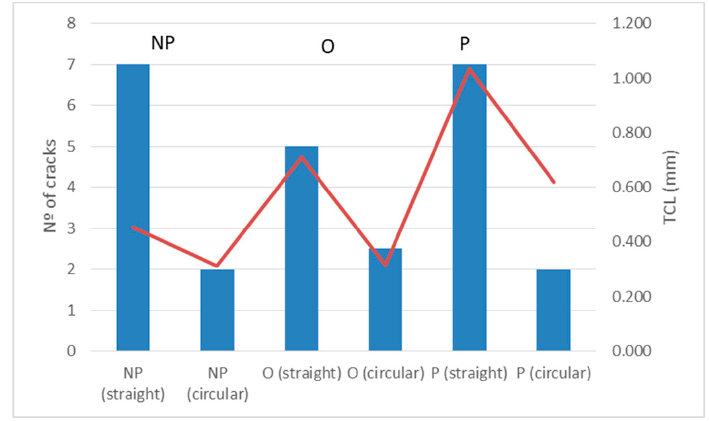
Figure 11. Number of cracks (blue bars) and TCL (red line) in bead-on-plate cross-sections of moulds O, P, and NP with 9 mm thickness. Laser power 2330 W.